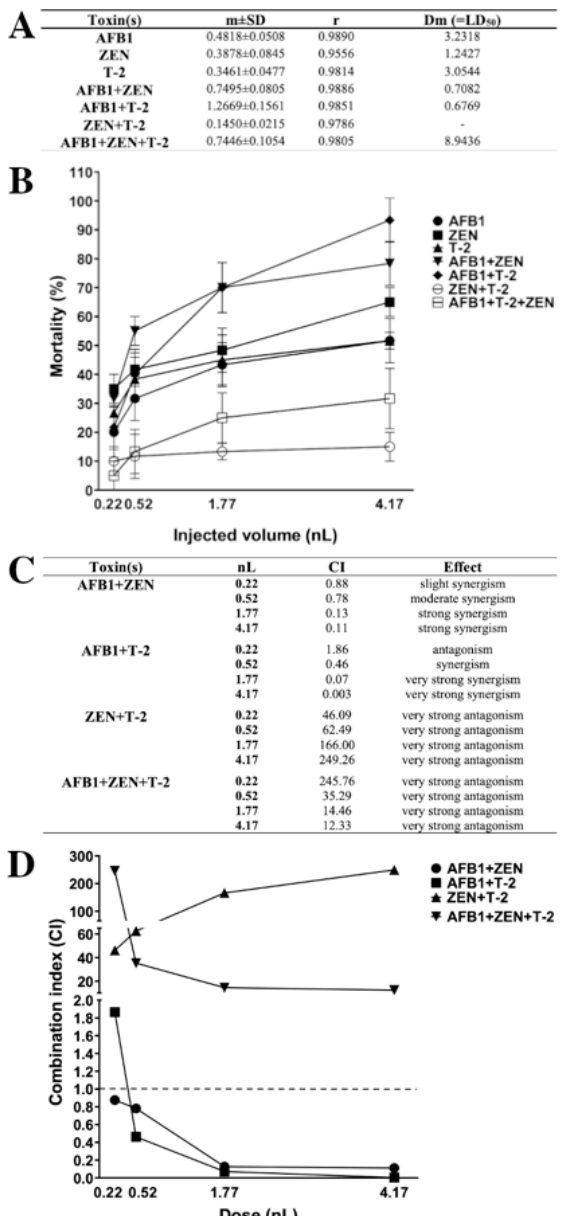
Figure 9. Lethal dose (LD 50 ) values ( A ) and mortality curves ( B ) of mycotoxins and mixtures in zebrafish embryos (m: slope of dose-effect curve, r: compliance parameter for goodness of fit, Dm: dose that produces 50% effect, LD 50 ). Type of the interaction between mycotoxins ( C ) and combination index plot of different mixtures ( D ) at each injected dose (nL). Values below and above the dashed line (CI = 1) mean synergism and antagonism. Values were calculated with CompuSyn software [105].